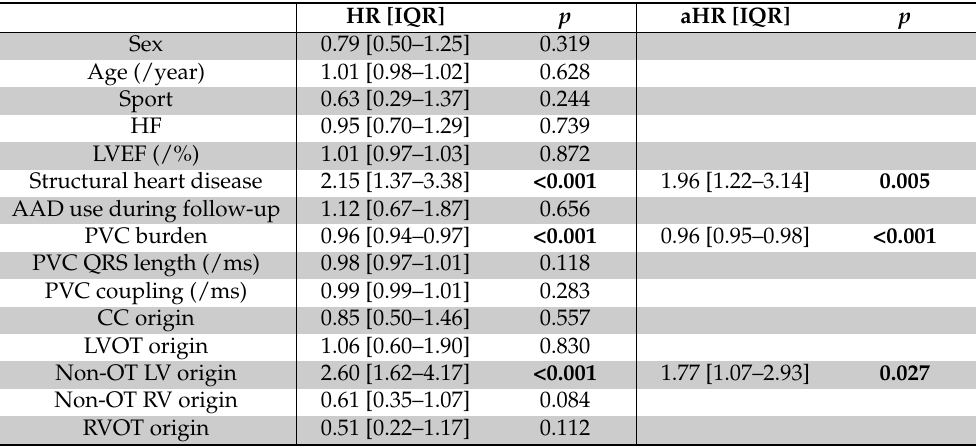
Figure 2. Clinical success of PVC catheter ablation stratified by arising zones, graphically displayed by Kaplan–Meier curves. Table 4. Primary outcome